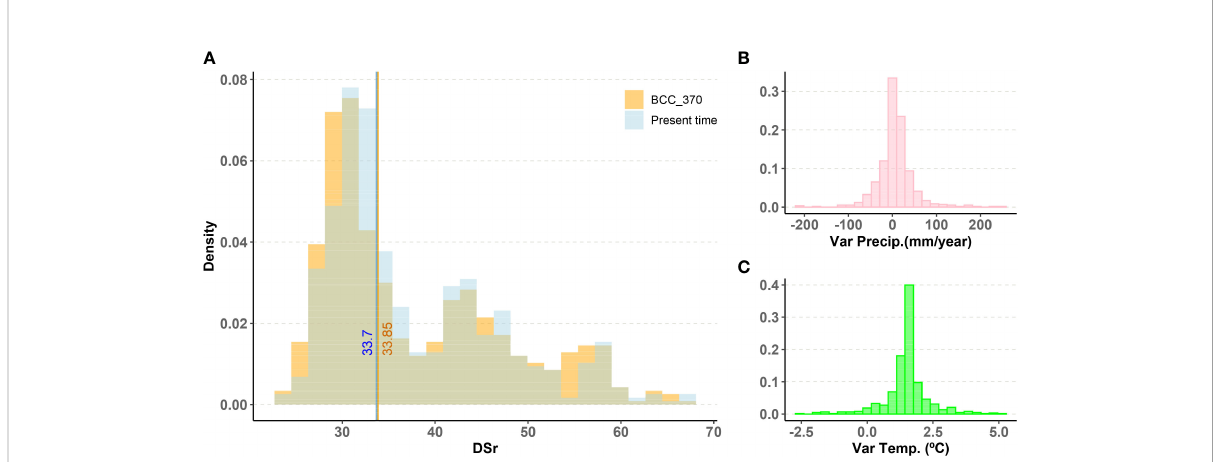
FIGURE 2 (A) Histogram of DSr prediction using Random Forest for non-evaluated wild populations in present time and in the future under BCC370 climate change model. Vertical lines mark the median value of each distribution. (B) , (C) Histograms of variation of average annual precipitation and average annual temperature between present time and future conditions under BCC370 climate